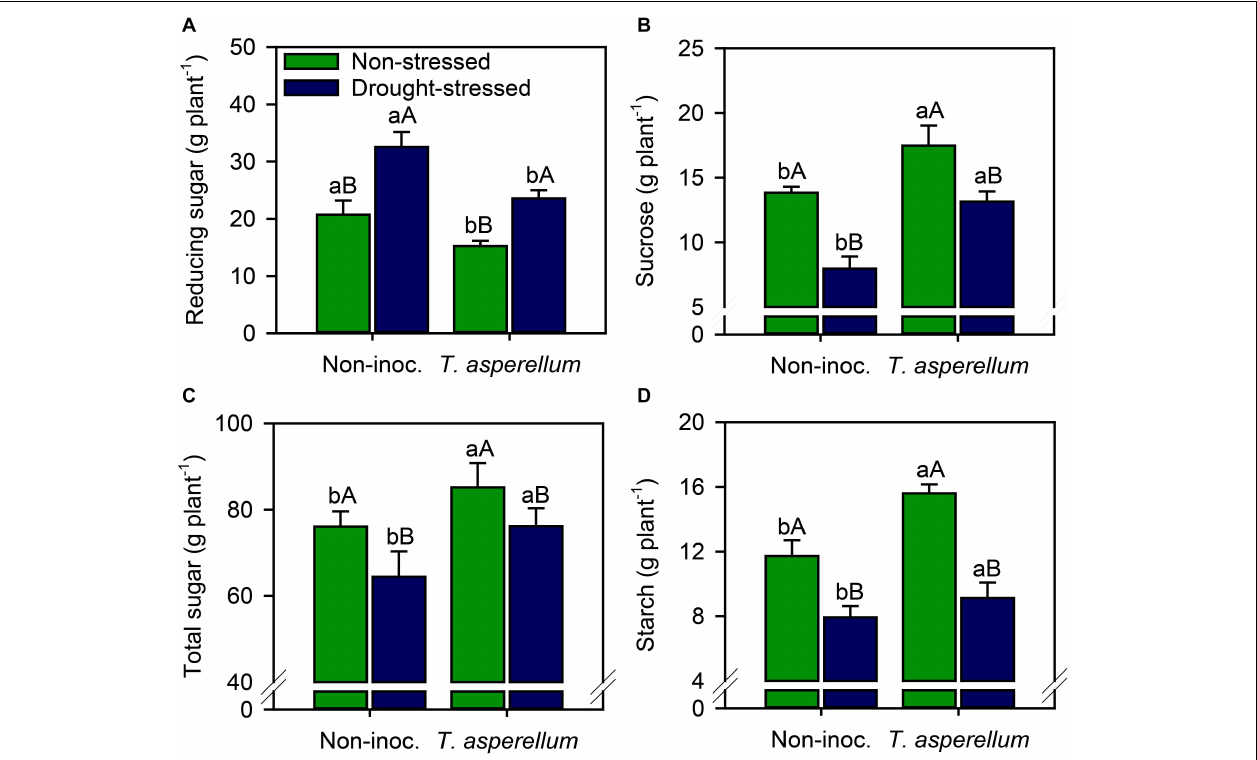
FIGURE 5 | Reducing sugar (A) , sucrose (B) , total sugar (C) , and starch (D) concentrations in sugarcane leaves according to the treatments. Different lowercase letters indicate significant differences between presence and absence of moderate drought stress, and different capital letters indicate significant differences between presence and absence of inoculation with T. asperellum by Fisher’s protected LSD test at p ≤ 0.05. Error bars express the standard error of the mean ( n =